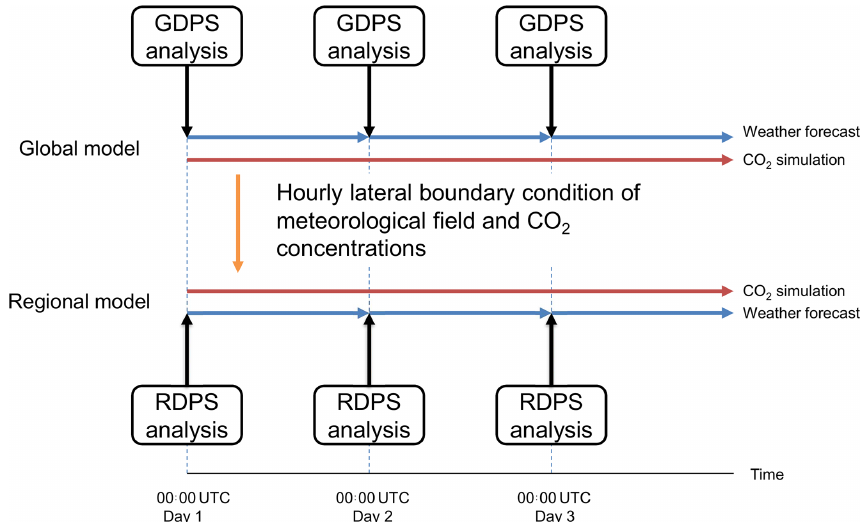
Figure 2. Schematic diagram of GEM–MACH–GHG global and regional forward model cycles. Meteorological analyses are from CMC’s operational global deterministic prediction system (GDPS) and regional deterministic prediction system (RDPS). Global and regional 24h weather forecasts start at 00:00UTC each day with operational analyses, while CO 2 concentrations are kept during cycles. The global forward model provides the lateral boundary condition of meteorological and CO 2 fields to the regional forward model every